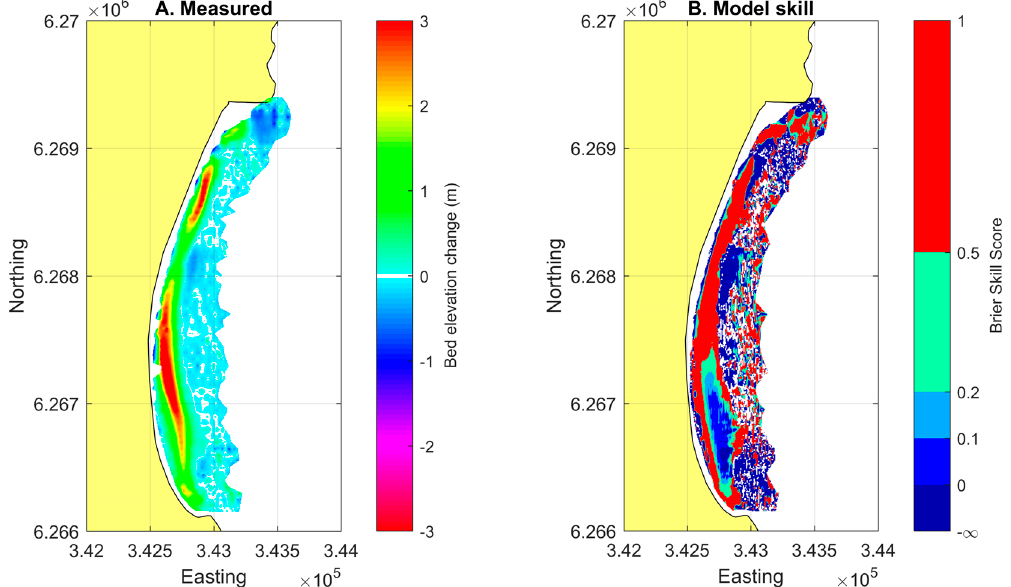
Figure 4. Measured morphological change (in metres) during the June 2016 storm event ( A ) and model skill in replicating observed change ( B ). The pre ‐ and post ‐ storm surveys in ( A ) extend from ~2 m to ~15 m water depth. The colour scheme in ( B ) reflects the Brier skill assessment of [32]. Morphological change within the vertical error of the surveyed data (±0.03, [21]) was omitted from both plots.